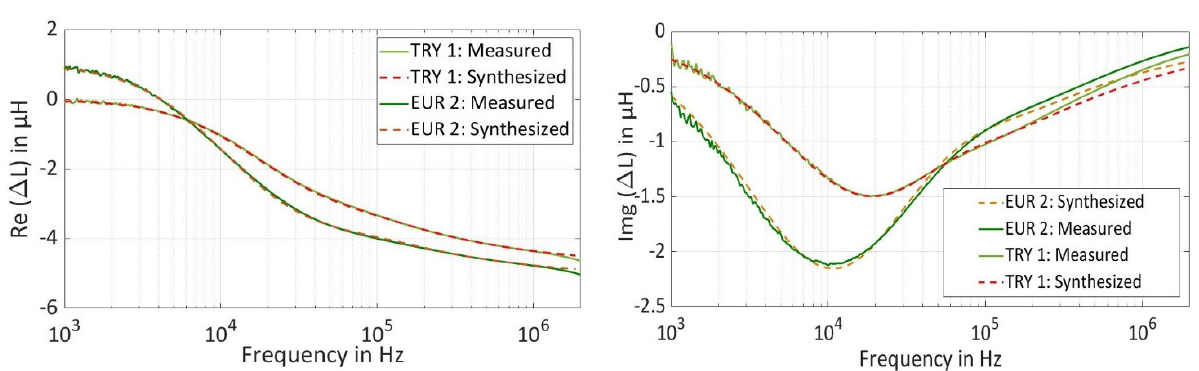
Figure 4. ( a ) Real Value of Measured and Synthesized Intermediate Inductance Spectra for EUR 2 and TRY 1 Coin. ( b ) Imaginary Value of Measured and Synthesized Intermediate Inductance Spectra for EUR 2 and TRY 1 Coin.